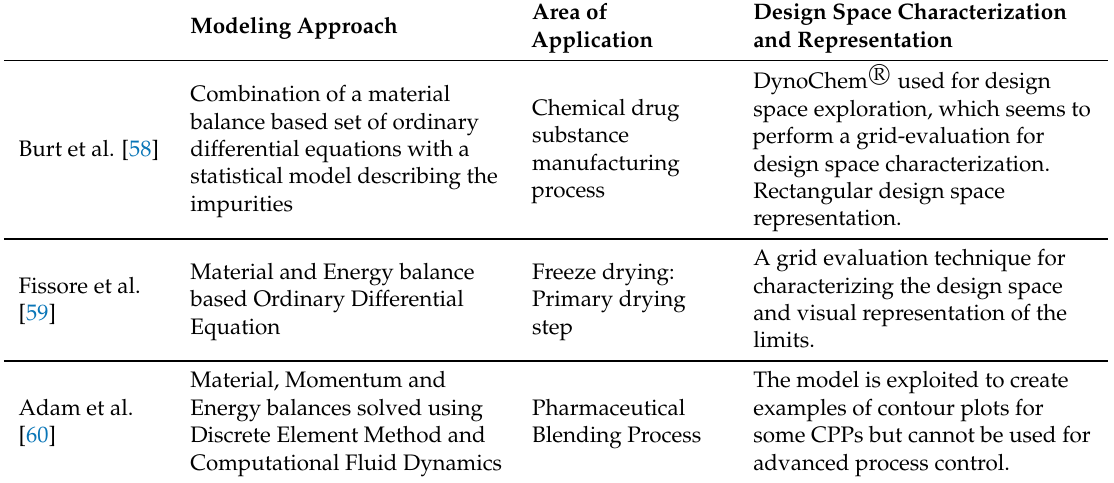
Table 1. Publication reporting Dynamic Design Space approaches. The area of application, the dynamic modeling approach and the design space characterization and representation are detailed.